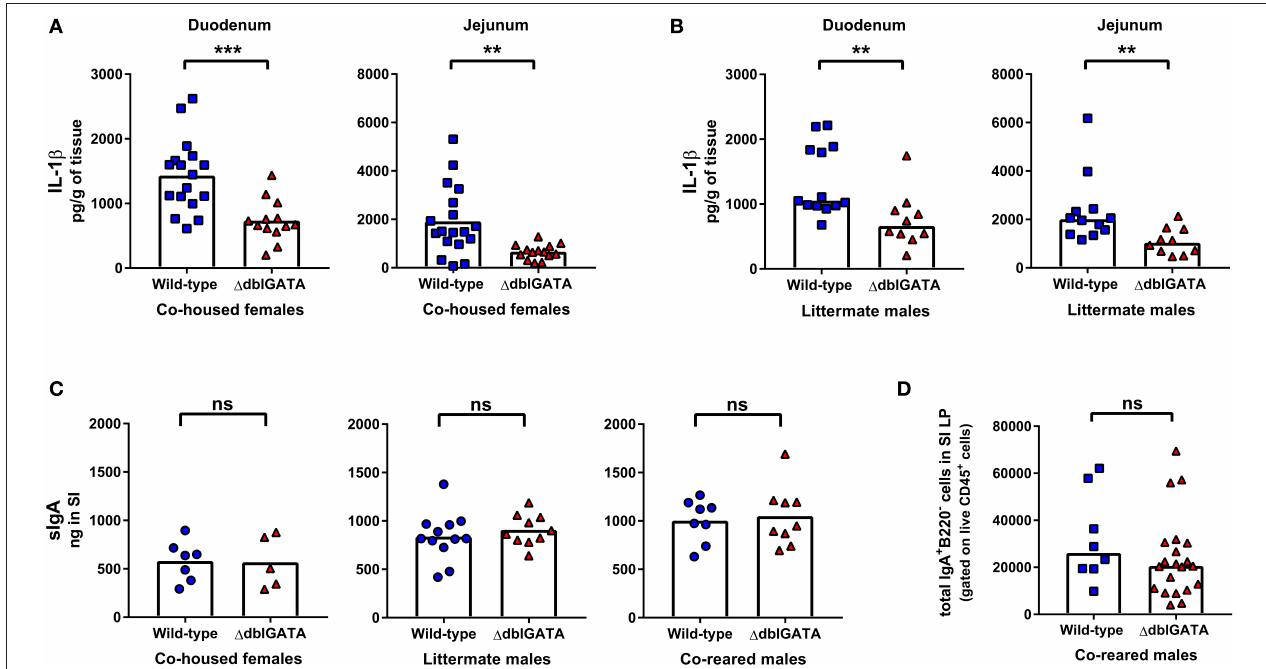
FIGURE 3 | 1 dblGATA mice show reduced small intestinal levels of IL-1 β compared to wild-type mice but equivalent levels of sIgA in small intestinal content. 6–11 week old female wild-type and 1 dblGATA BALB/cJ mice were co-housed for 1 week (“co-housed”) prior to collecting small intestinal tissue or content. Male wild-type and 1 dblGATA BALB/cJ mice were raised in the same cage from birth but born to dams of different genotypes (“co-reared”) or raised in the same cage from birth and born to heterozygous 1 dblGATA dams (“littermates”), and small intestinal (SI) tissue or content were collected when mice were 6–12 weeks old. (A) IL-1 β was measured in homogenized duodenum and jejunum samples using a cytometric bead array assay. Data shown are pooled from three independent experiments, with a combined n = 13–17 in each group. Column heights are at the mean value for each group and data were analyzed by an unpaired t -test. (B) IL-1 β was measured in homogenized duodenum and jejunum samples using a cytometric bead array assay. Data shown is pooled from two independent experiments, with a combined n = 10–13 in each group. Column heights are at the median value for each group and data were analyzed by a Mann-Whitney test. (C) sIgA was quantified in SI content by ELISA. Data shown from co-housed females are pooled from two independent experiments, with a combined n = 5–7 in each group. Data shown from male littermates are pooled from three independent experiments, with a combined n = 10–12 in each group. Data shown from co-reared males are pooled from two independent experiments, with a combined n = 8–9 in each group. Column heights are at the mean value for each group and data were analyzed by an unpaired t -test. (D) IgA-producing plasma cells (Live CD45 + IgA + B220 − cells) were quantified by flow cytometry in the small intestinal lamina propria (SI LP). Data shown are from three independent experiments, with a combined n = 8–21 in each group. Column heights are at the median value for each group and data were analyzed by a Mann-Whitney test. Each data point is representative of an individual mouse. ns, no statistical differences; ** = p ≤ 0.01; *** = p ≤